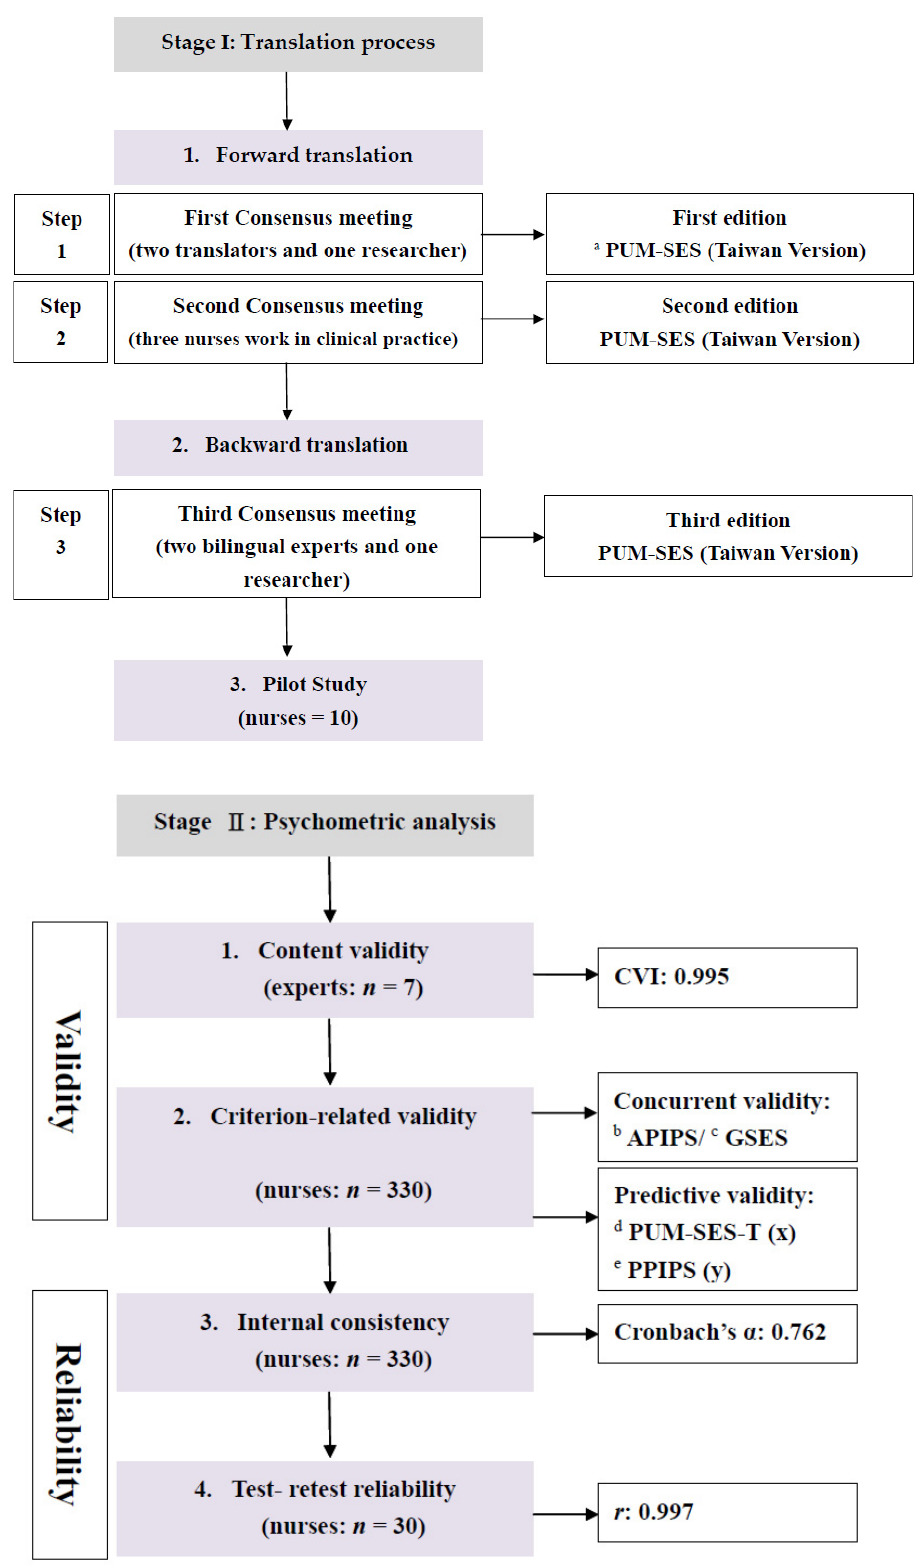
Figure 1. Step for translation and validation of the PUM-SES-T. a PUM-SES: Pressure Ulcer Manage- ment Self-Efficacy Scale. b APIPS: Attitude toward Pressure Injury Prevention Scale. c GSES: General Self-Efficacy Scale. d PUM-SES-T: Pressure Ulcer Management Self-Efficacy Scale Taiwanese version. e PPIPS: Practice toward Pressure Injury Prevention Scale.